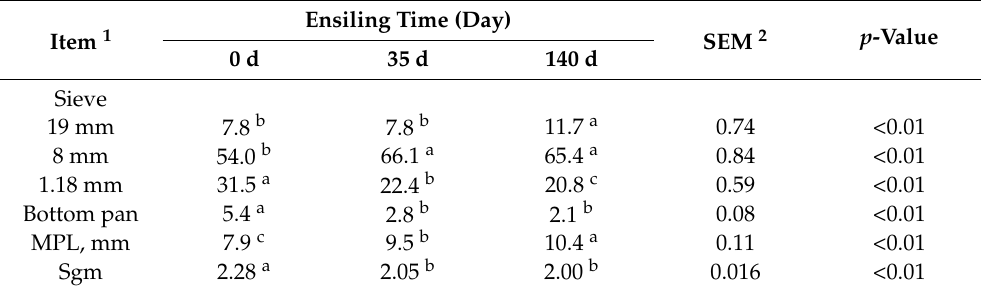
Table 7. Effect of ensiling time on particle size distribution and mean particle length in whole-plant corn silage harvested with a self-propelled forage harvester.